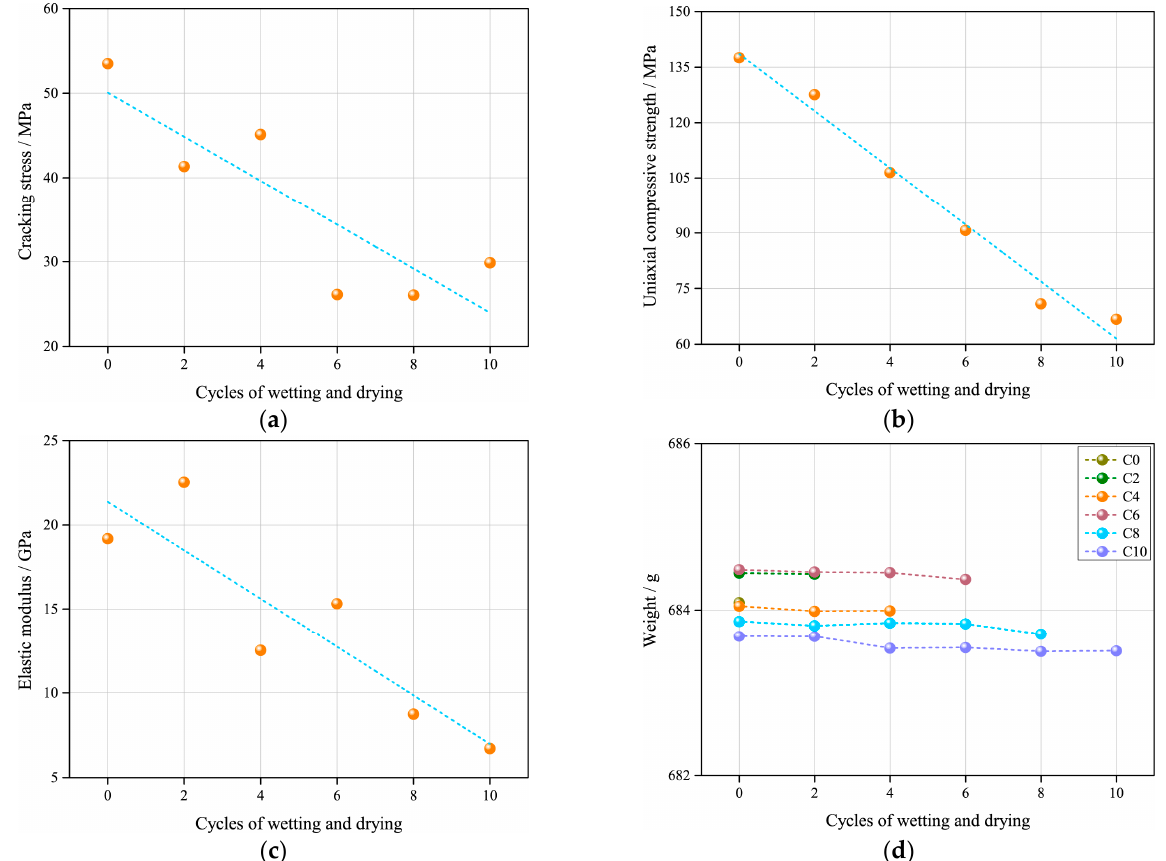
Figure 10. Correlations of cracking stress ( a ), uniaxial compressive strength ( b ), elastic modulus ( c ) and weight ( d ) versus cycles of wetting and drying.